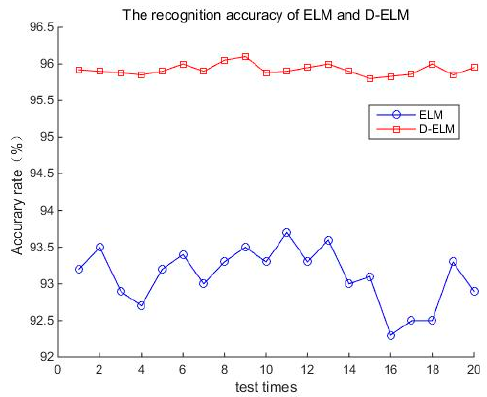
Figure 10. Accuracy of D-ELM and ELM after multiple tests.